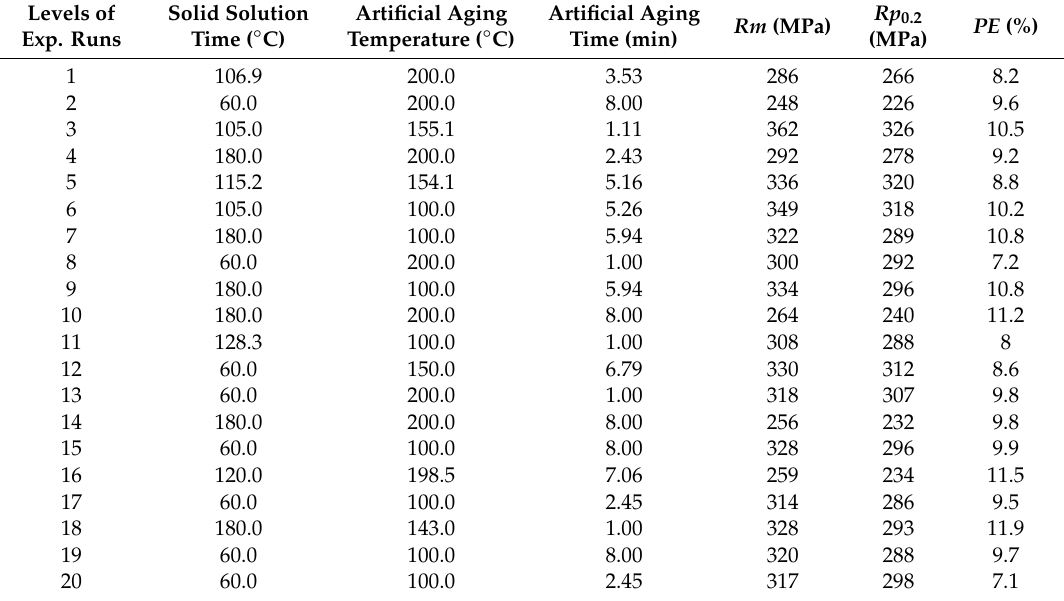
Table 1. Experimental points according to D-Optimal design with tensile testing results for solid state recycled aluminum alloy EN AW